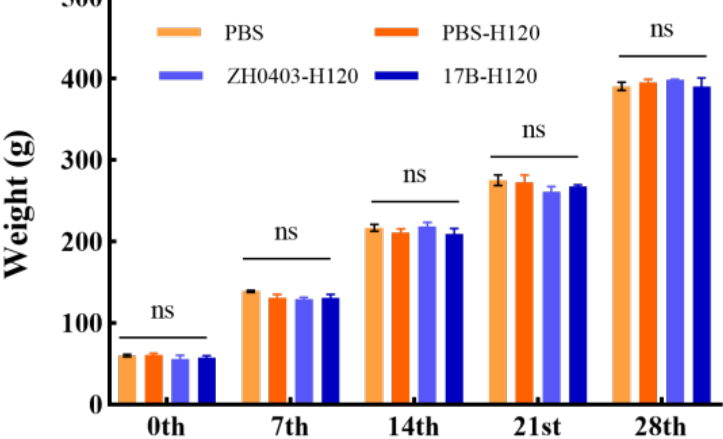
Figure 11. Viral RNA load level in trachea, kidney, and liver determined via absolute quantitative qRT-PCR. One-way ANOVA with Tukey’s test was used for statistical analysis; *: p < 0.05; **: p < 0.01, ***: p < 0.001.